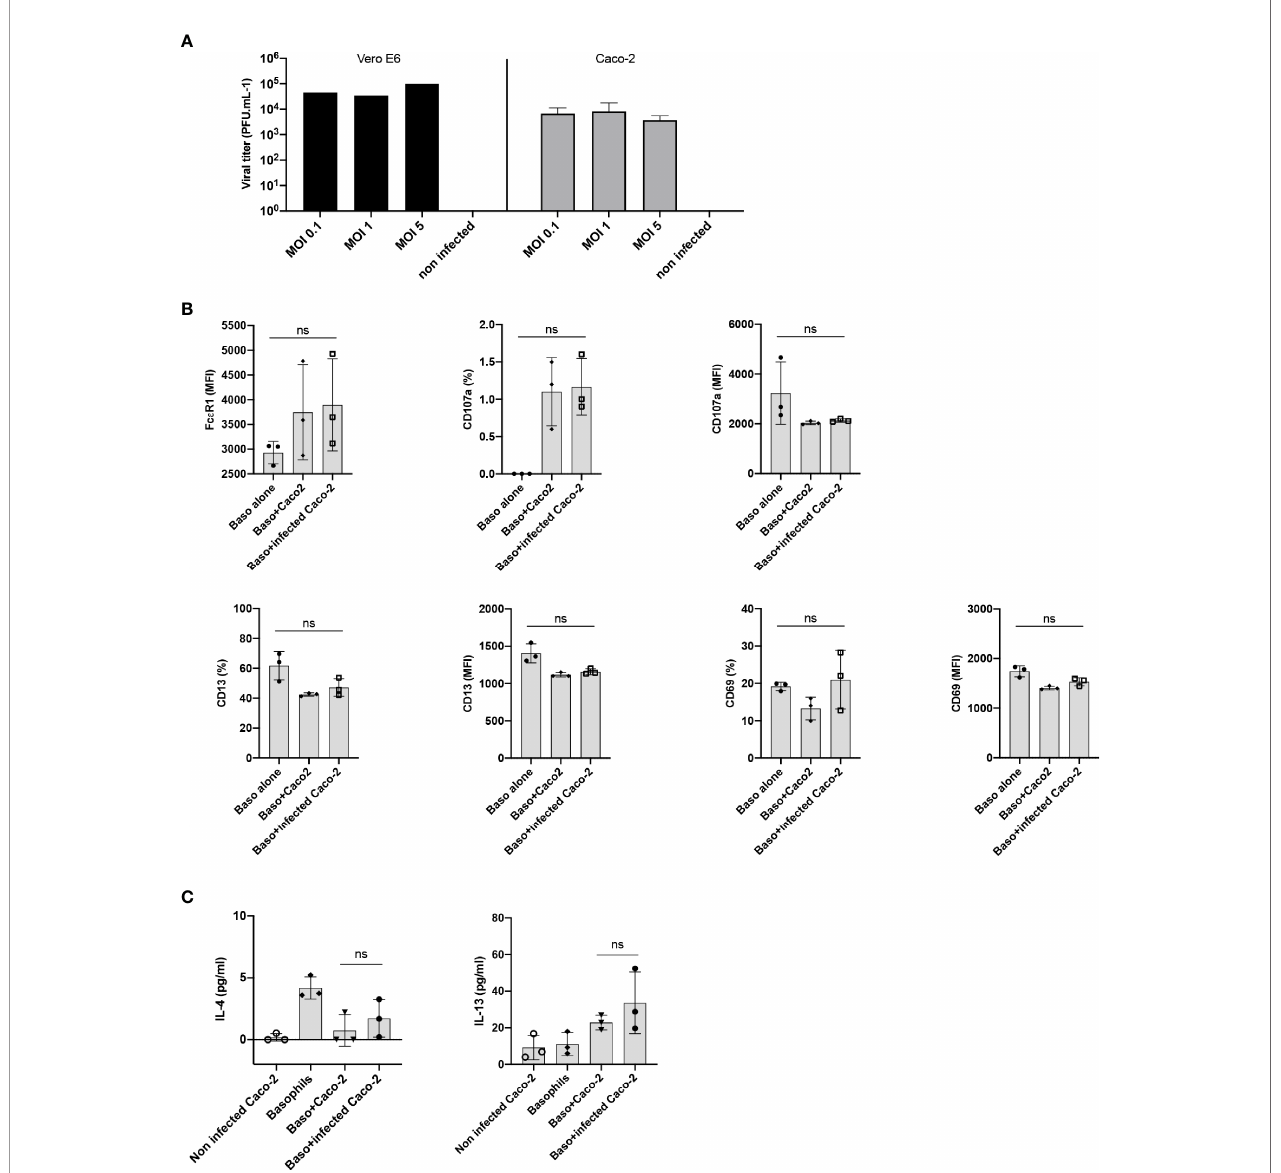
FIGURE 3 | Lack of basophil activation by SARS-CoV-2 infected epithelial cells. (A) Caco-2 cells permit SARS-CoV-2 replication. Caco-2 cells (1.5x10 5 cells per well/24 well plate) in duplicates were infected with SARS-CoV-2 at the MOI of 0.1, 1 and 5. Viral titers were evaluated after 72 h post-infection. Data were presented as mean ± SD. Infection of Vero E6 cells with SARS-CoV-2 was used as a control. (B, C) Basophils were cultured as follows: basophils alone (0.1x10 6 cells/100 µl), basophils (0.1x10 6 cells/100 µl) + Caco-2 (5x10 4 cells/100 µl), and basophils + Caco-2 infected with SARS-CoV-2. Cell phenotype was evaluated by fl ow cytometry after 24 h. (B) Expression of Fc ϵ R1, CD107a, CD13, CD69 on basophils (% positive cells and/or median fl uorescence intensities (MFI), mean ± SD; n = 3independent donors). (C) The amount (pg/ml) of secreted IL-4 and IL-13 in the cell-free supernatant from the above experiments (mean ± SD, n = 3 independent donors). ns, not signi fi cant, one-way ANOVA Friedman test with Dunn ’ s multiple comparisons